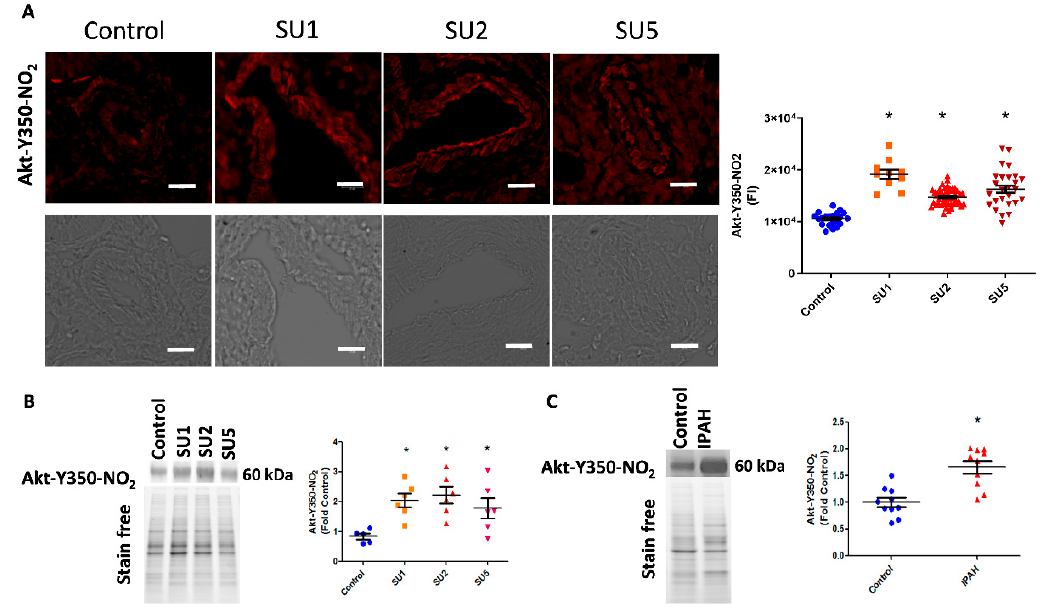
Figure 2. Akt nitration, an early event in PAH. ( A ) Immuno-fluorescence imaging indicated increased Akt nitration in the endothelial and smooth muscle layer of pulmonary arteries of rats after one, two, and five weeks of PAH progression (scale bar is 20 µm). FI, fluorescent intensity; SU1, rats were analyzed after 1 week of SU5416 and hypoxia treatment; SU2, rats were analyzed after 2 weeks of SU5416 and hypoxia treatment; SU5, rats were analyzed after 5 weeks of SU5416 treatment (3 weeks of hypoxia with a following 2 weeks of normoxia). Mean ± SE, N = 10–50 arteries, * p < 0.05 versus control by ANOVA. ( B ) Western blot analysis showed significantly increased expression of nitroY350 Akt in sugen treatment groups. Data expressed as mean ± SE, N = 6–8, * p < 0.05 versus control by ANOVA. ( C ) Western blot analysis of healthy controls and idiopathic pulmonary arterial hypertension (IPAH) patients indicated significantly increased nitroY350 Akt signal in IPAH. Data expressed as mean ± SE, N = 10, * p < 0.05 versus control by Mann–Whitney U t-test.